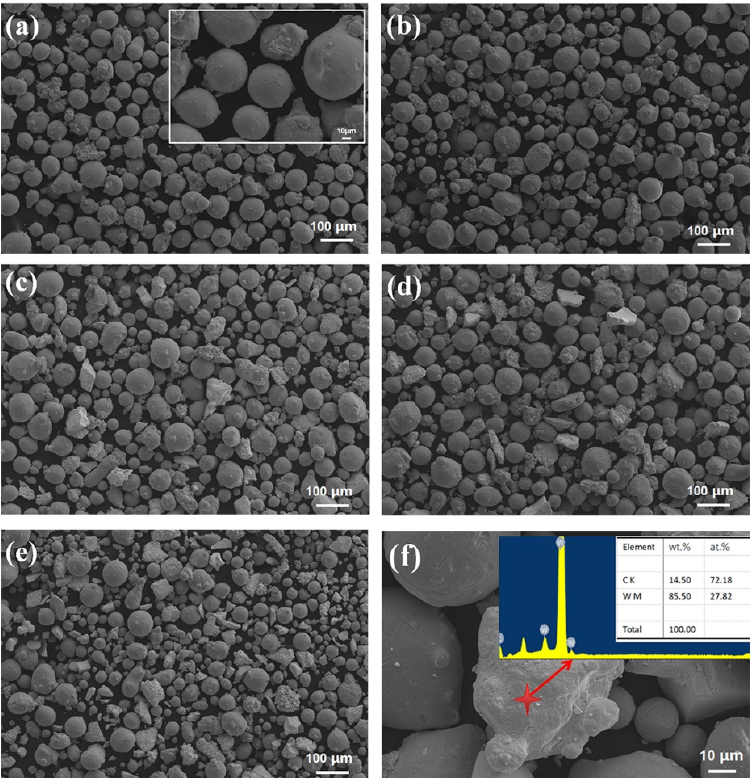
Figure 2. SEM images and EDS spectra of mixed powders: ( a ) CoCrFeNi; ( b ) CoCrFeNi+10 wt.%WC; ( c ) CoCrFeNi+20 wt.%WC; ( d ) CoCrFeNi+30 wt.%WC; ( e ) CoCrFeNi+40 wt.%WC; ( f ) EDS spectra of irregular WC particles.